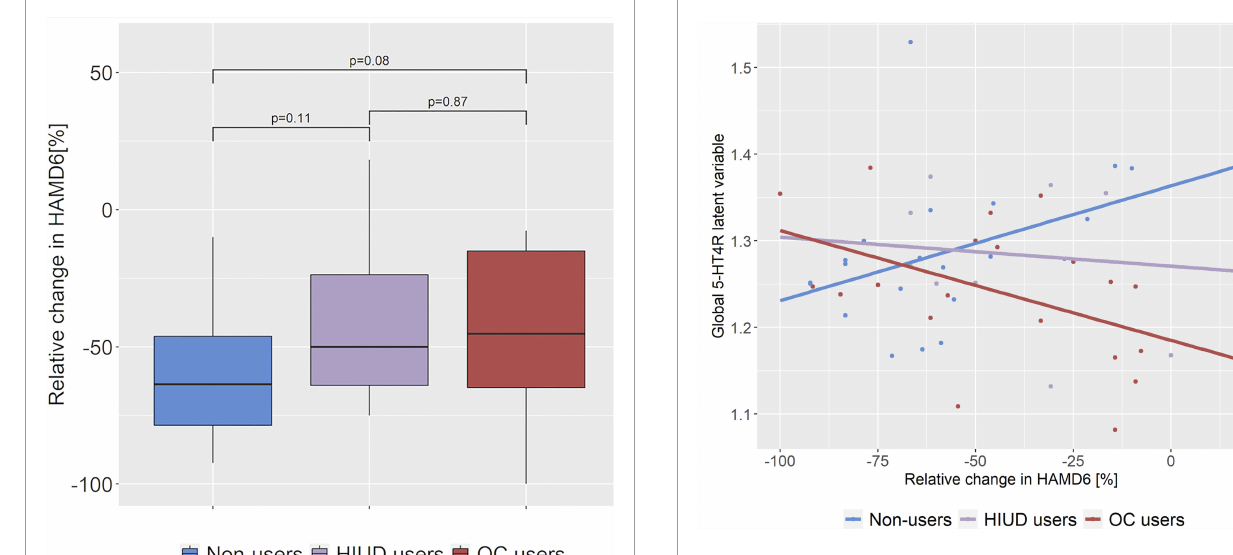
layer (B) shows how this association differs in the HC users from the non-users. The regional estimates show that per 10% less improvement in HAMD 6 , the OC users had 2.6-4.0% (p adj ≤ 0.03) lower binding at baseline compared to the non-users. The third layer (C) shows the estimated effect of HC use on 5-HT4R